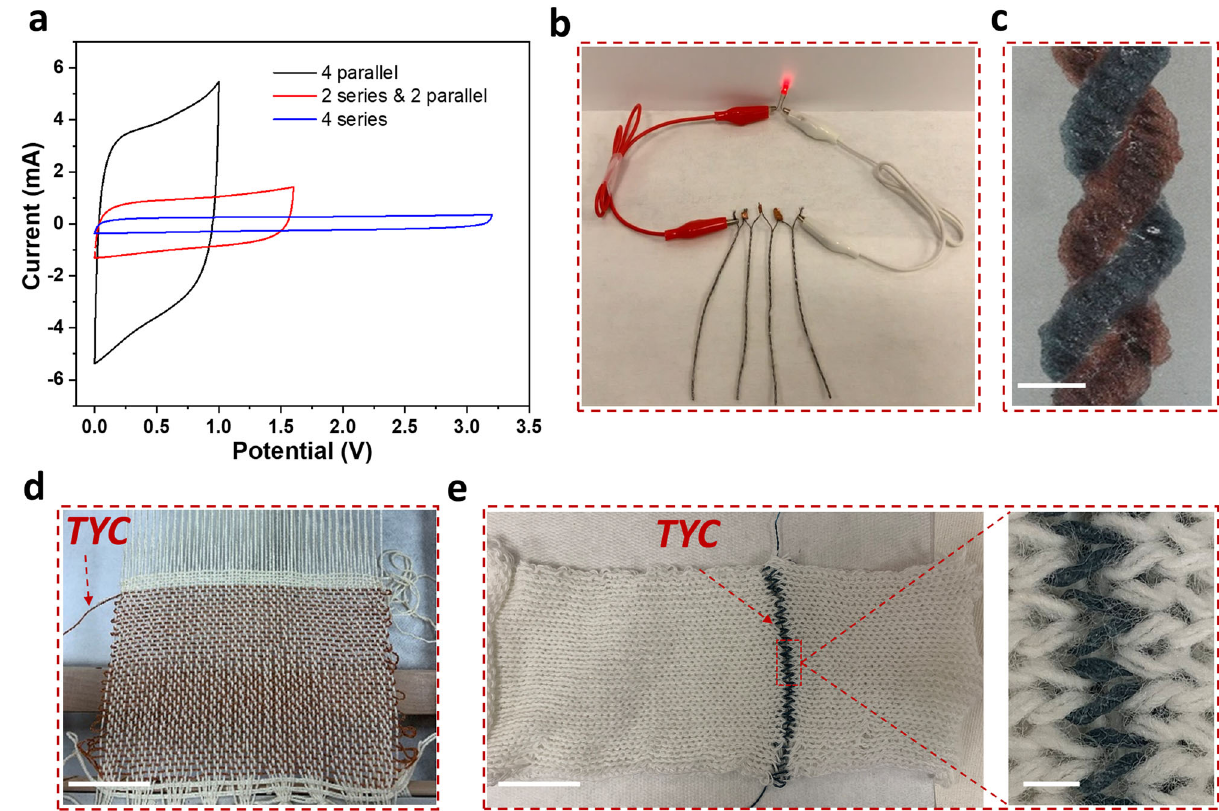
Fig. 4 Demonstration of TYCs for real applications. a CV curves (40 mV s − 1 ) of four TYCs in different connecting strategies; b Photo of four serially connected TYCs lighting an LED; c Photo of a TYC with each electrode wrapped with different color of nylon threads (Scale bar: 1 mm); d Photo a woven fabric with TYCs (orange) incorporated as weft yarns (Scale bar: 10 cm); e Photo of a knitted fabric with a one-meter long TYC (dark blue) incorporated (Scale bar in left: 10 cm; right: 2